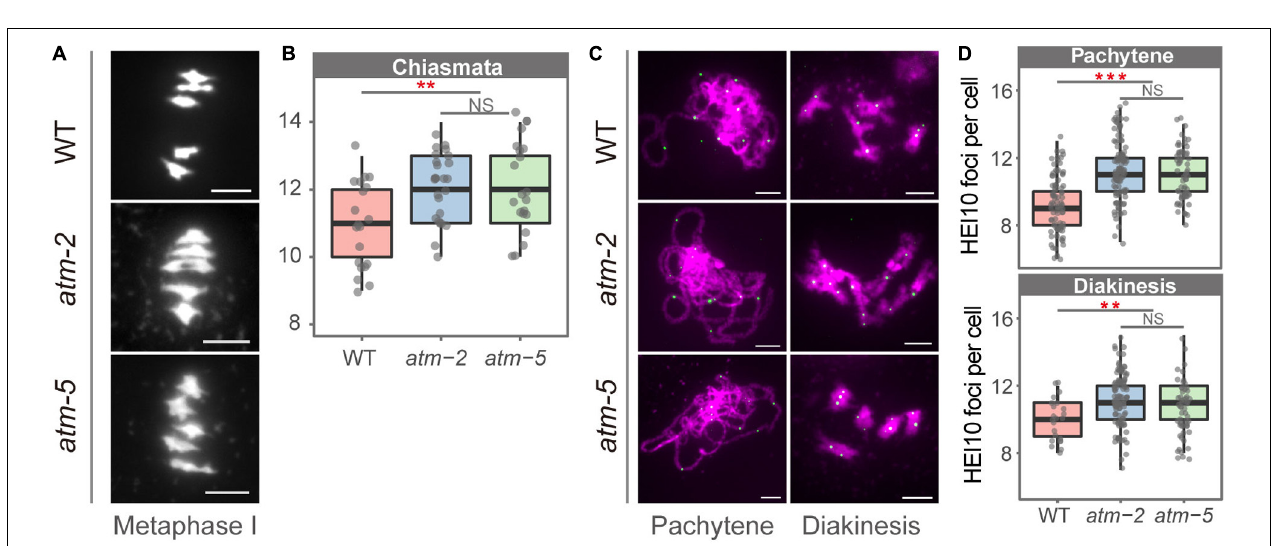
FIGURE 5 | Number of chiasmata in wild type and atm mutants. (A) Bivalents in metaphase I meiocytes in wild type and atm mutants. The number of chiasmata of each chromosome was marked aside. (B) Number of chiasmata per cell in wild type (10.85 ± 1.18, n = 20) and atm mutants ( atm-2 : 12 ± 1.02, n = 25, P = 2.72E-3; atm-5 : 12.01 ± 1.37, n = 21, P = 7.76E-3, Wilcoxon Rank Sum test). For each allele, metaphase I cells used for chiasmata counting are from about 30 plants. The atm-2 and atm-5 are two independent atm mutant alleles. (C) Immunolocalization of HEI10 (green dots) on pachytene ( atm-2 : 11.3 ± 1.82, n = 113, P = 7.59E-13; atm-5 : 11.05 ± 1.47, n = 65, P = 3.25E-09) and diakinesis ( atm-2 : 11.25 ± 1.49, n = 110, P = 2.18E-04; atm-5 : 10.94 ± 1.41, n = 48, P = 7.17E-03) stage chromosomes (magenta) in wild type and atm mutants. Bar = 5 µ m. (D) Number of HEI10 foci in wild type and atm mutants. Cells counted in each allele are from at least 30 plants. The atm-2 and atm-5 are two independent atm mutant alleles.